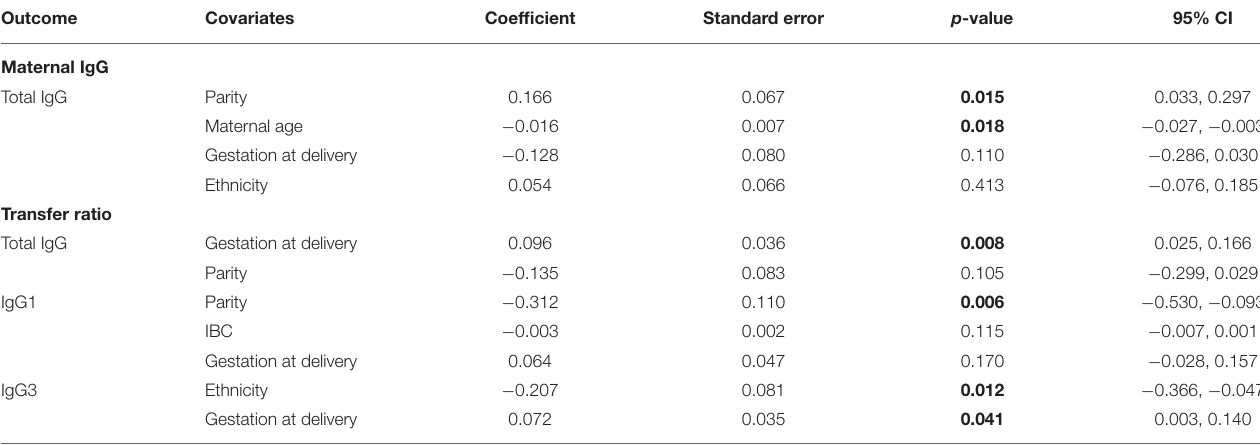
TABLE 5 | Adjusted effects of clinical parameters on maternal and cord antibody levels, and transfer ratios using multiple linear regression based on n = 106 for total IgG and n = 116 for IgG